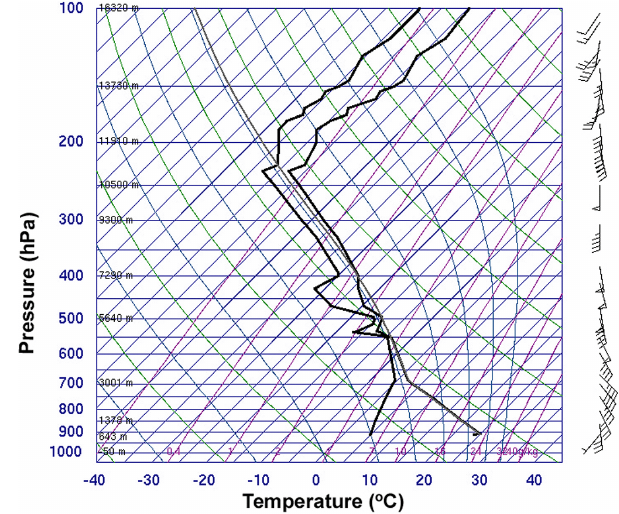
Figure 2. Atmospheric sounding launched near Edmonton, Alberta, on 29 May 2001. The right black line represents the temperature, and the left black line corresponds to the dew-point temperature. This weather information is from the University of Wyoming De- partment of Atmospheric Science (http://weather.uwyo.edu/s).